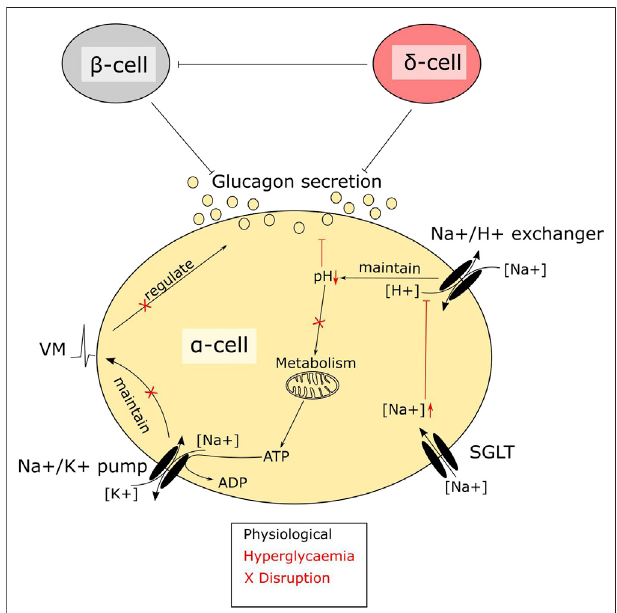
FIGURE2| AcentralroleofSGLTsinalphacellfunction.SGLTsmediate sodium in fl ux in pancreatic alpha cells. Intracellular sodium levels are tightly linked to alpha cell function. Disruptions due to hyperglycaemia-mediated accumulation of sodium interfere with alpha cell metabolism. The high intracellular sodium affects the function of sodium proton exchangers, resulting in lowering of pH. Maintenance of pH is crucial in alpha cells, as the intrinsic glucose sensing mechanism depends largely on metabolism. Metabolicenzymes,whicharesensitivetopH,will – whendisrupted – renderthe cells glucose blind, resulting in dysregulated glucagon